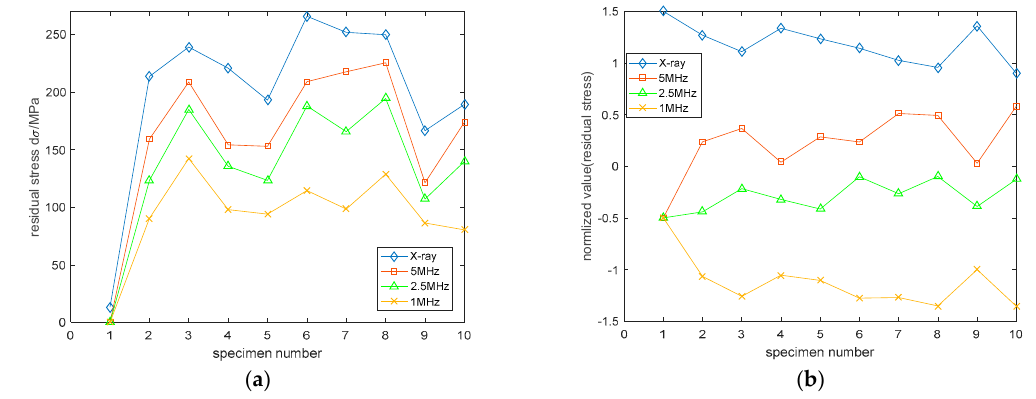
Figure 7. Comparison between X-ray and L CR waves for different specimens. ( a ) The residual stress for different specimens; ( b ) The normalized value of residual stress for different specimens.